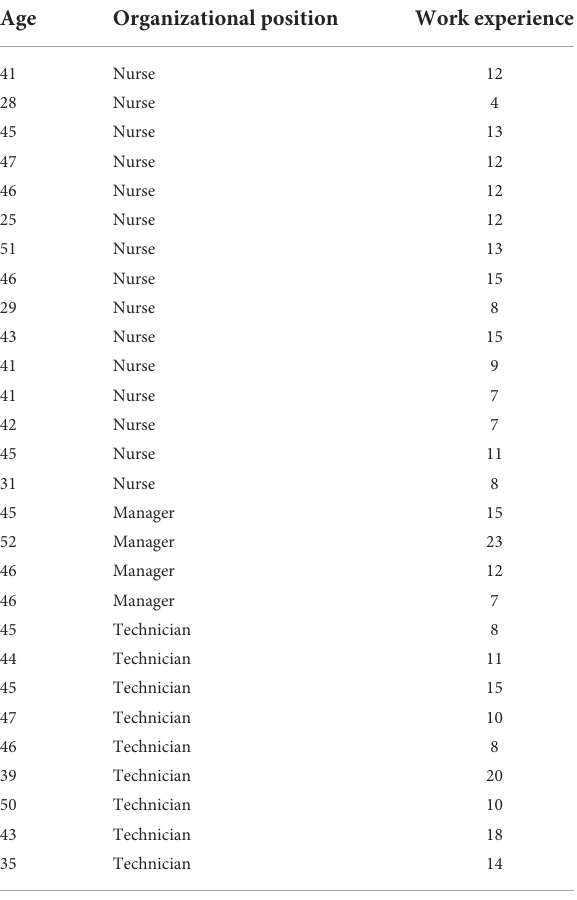
TABLE 2 Demographic information of